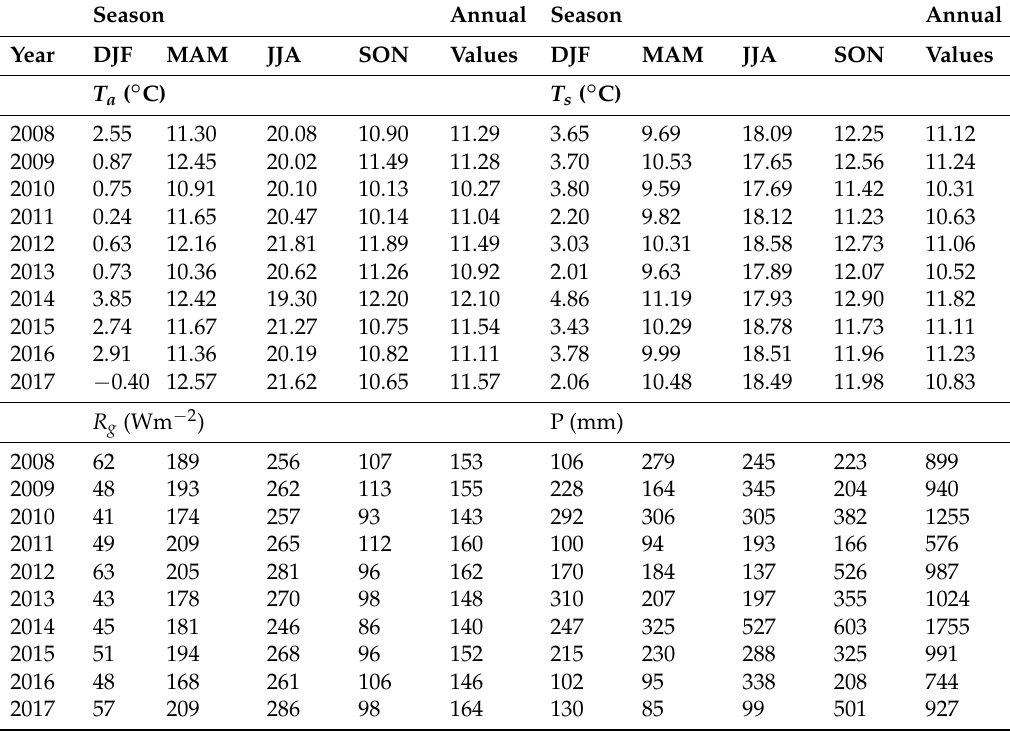
Table A5. Seasonal meteorological data; average air and soil temperature, average global radiation and sums of precipitation by season.